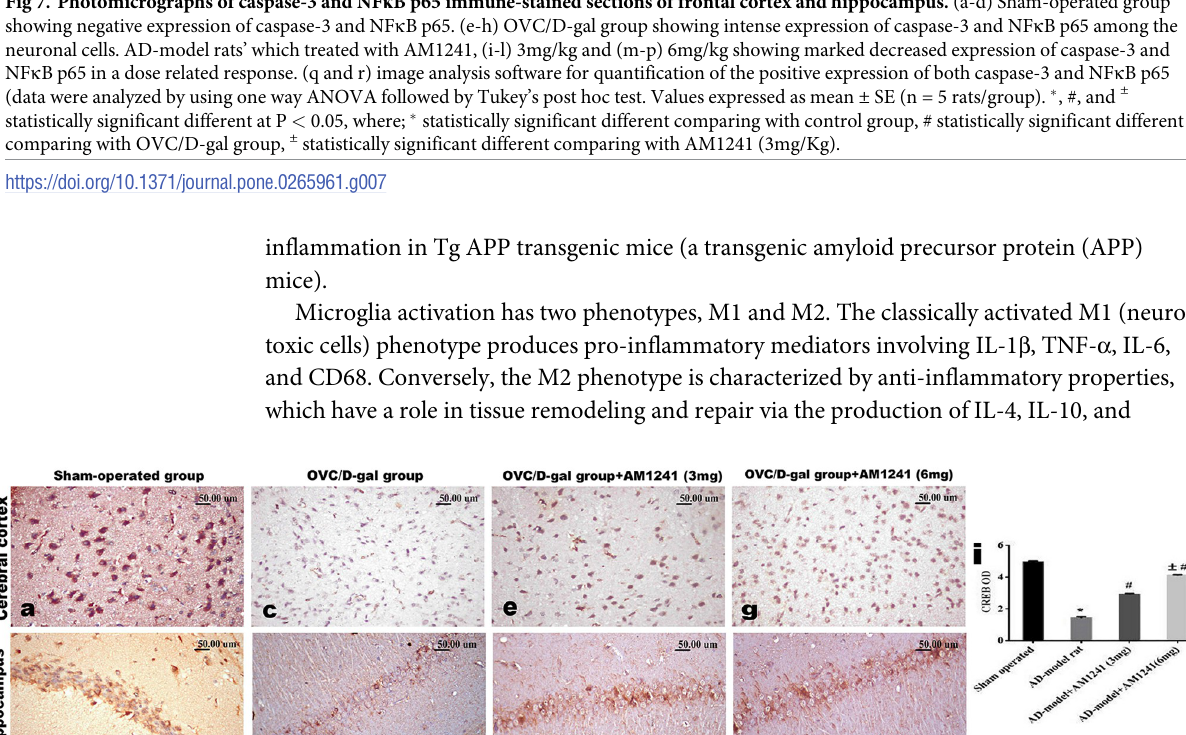
PLOS ONE | https://doi.org/10.1371/journal.pone.0265961 March 29,